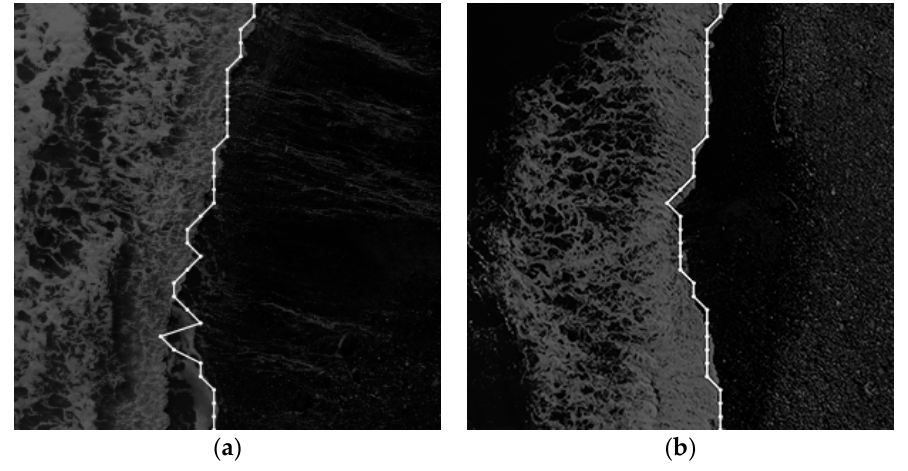
Figure 2. ( a , b ) Wave edge detection. Source: Author.